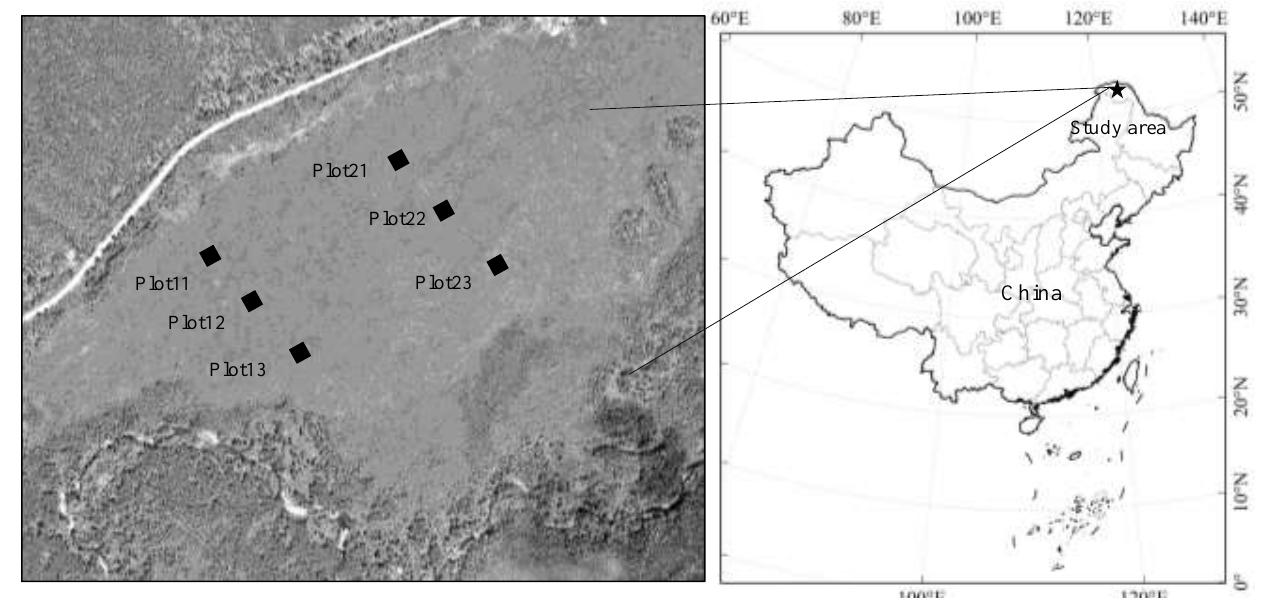
Figure 1. Location of the study site and sampling plots.